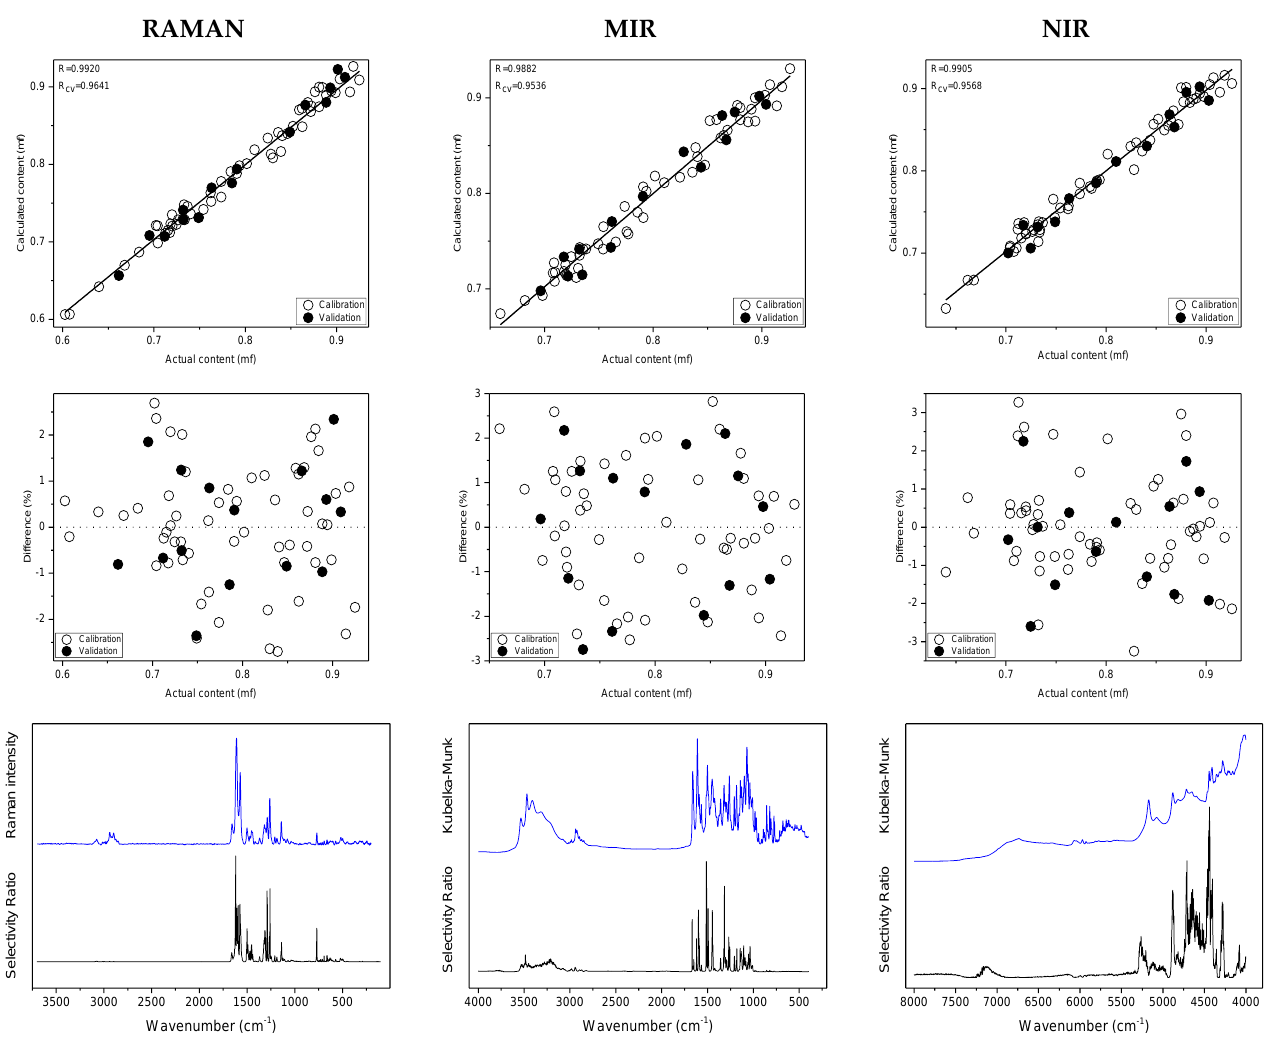
Figure 4. Prediction plots, relative errors, experimental spectra of hydrated diosmin (DSNM) (blue) and selectivity ratio (SR) (black) obtained on the basis of Raman, MIR and NIR spectra of calibration samples for Preparation 1; from the top.